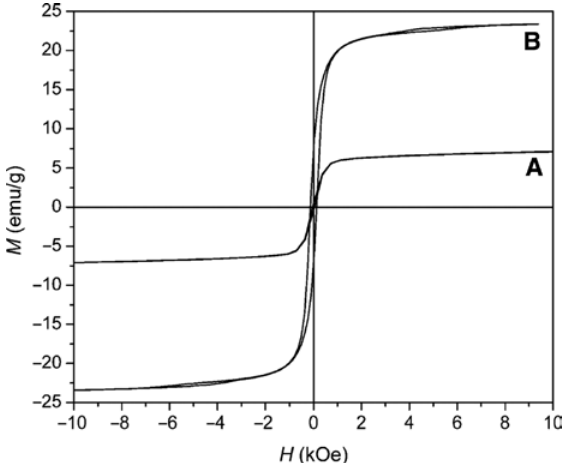
Figure 9: Coating of particles affects their magnetic properties. Magnetization measurement is therefore a good way to determine the influence of the prepared coating. (A) Magnetization versus magnetic field for the silica-coated particles and (B) “as prepared” particles. Reproduced with permission from IEEE: Transactions on Magnetism